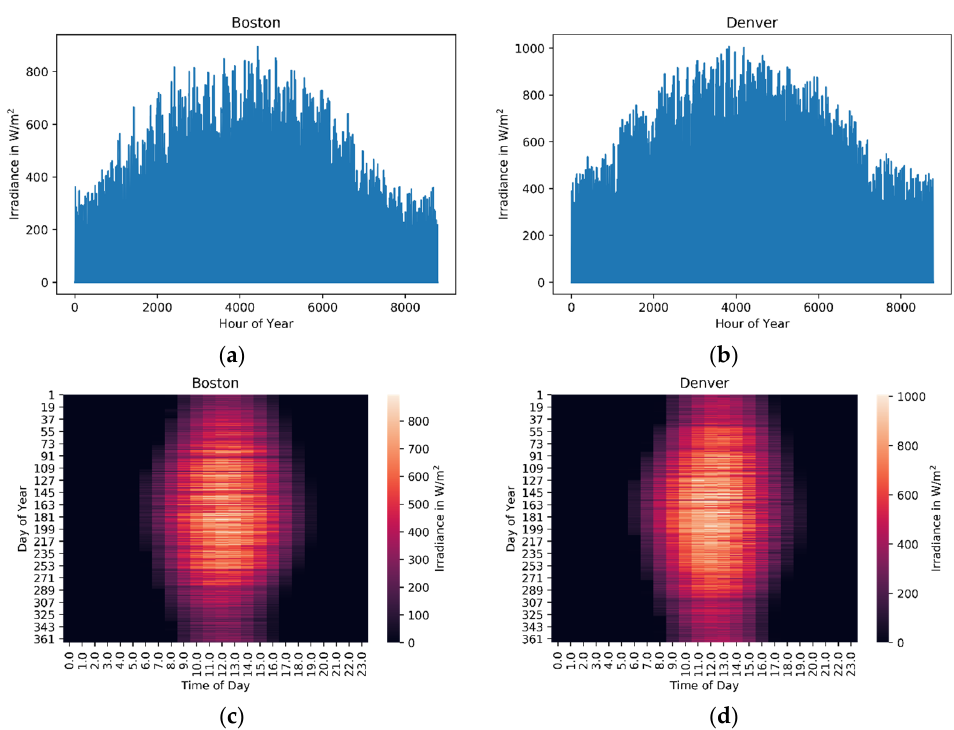
Figure 2. The 1D and 2D representations of average irradiance in Boston and Denver [34]. ( a ) 1D representation of average irradiance in Boston ( b ) 1D representation of average irradiance in Denver ( c ) 2D representation of average irradiance in Boston ( d ) 2D representation of average irradiance in Denver.